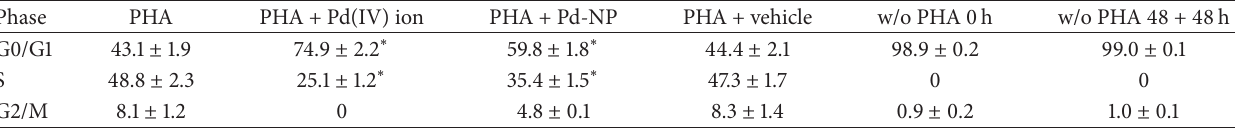
Table 1: Cell cycle distribution data of quiescent and PHA-activated PBMCs exposed to Pd-NP or Pd(IV) ion.